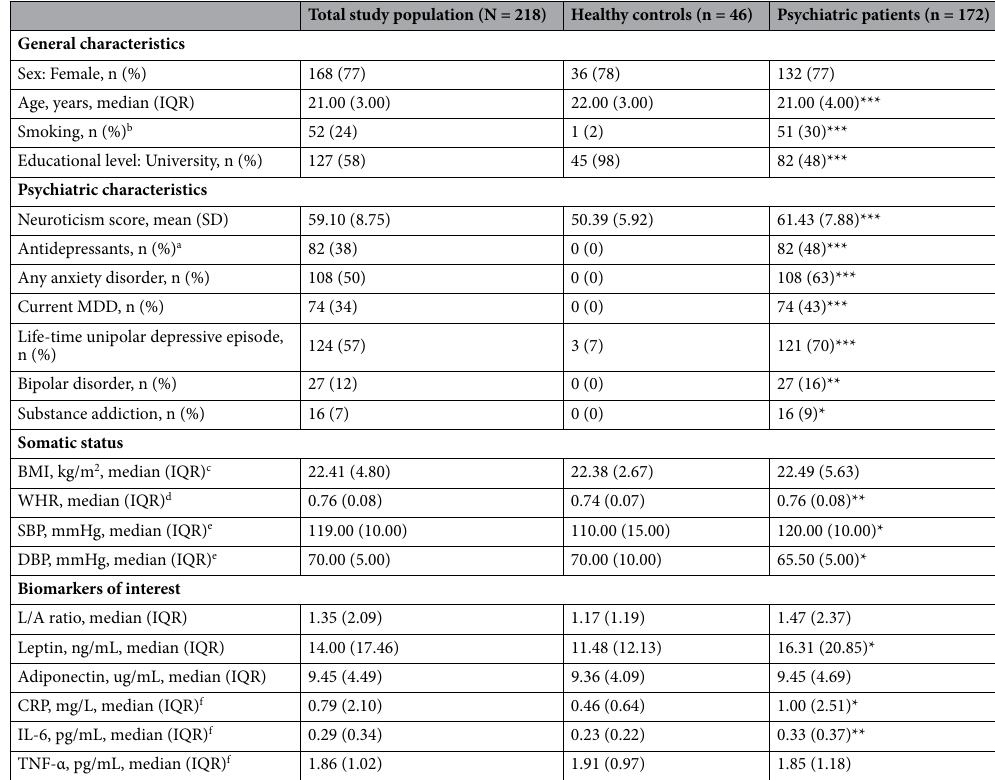
Table 1. Descriptive table of the study participants and comparisons between psychiatric patients and healthy controls. To test if there was a significant difference between patients and controls, the Chi-square test (or Fisher’s test when applicable) was used for the categorical variables and the Mann–Whitney test for the continuous variables. IQR interquartile range, BMI body mass index, WH R Waist-hip ratio, SBP systolic blood pressure, DBP diastolic blood pressure, L/A leptin/adiponectin. *p < 0.05, **p < 0.01, ***p < 0.001. a